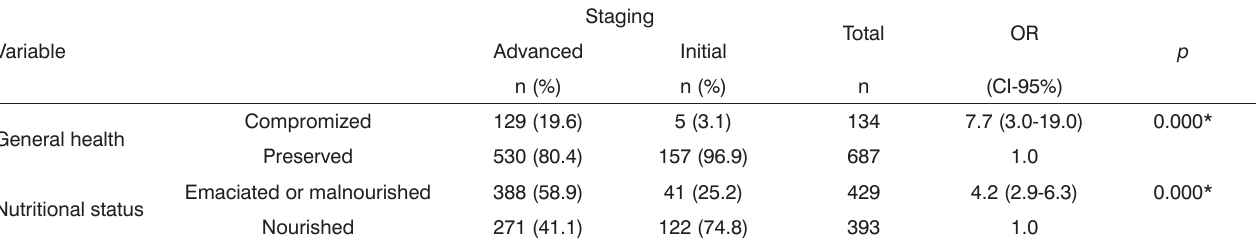
Table 4. Distribution of variables: general and nutritional status of patients with UADT SCC as per staging and binary logistic regression analysis. Odds Ratio (OR) with a confidence interval of 95% (CI).